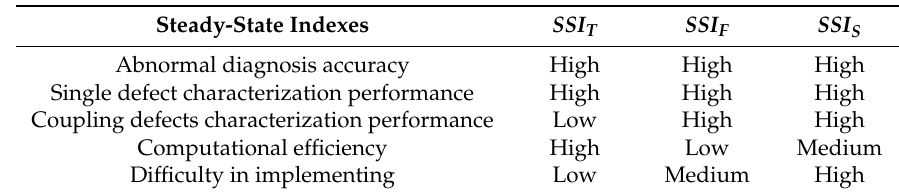
Table 2. Comparisons of the performances among steady-state indexes in the time, frequency, shape